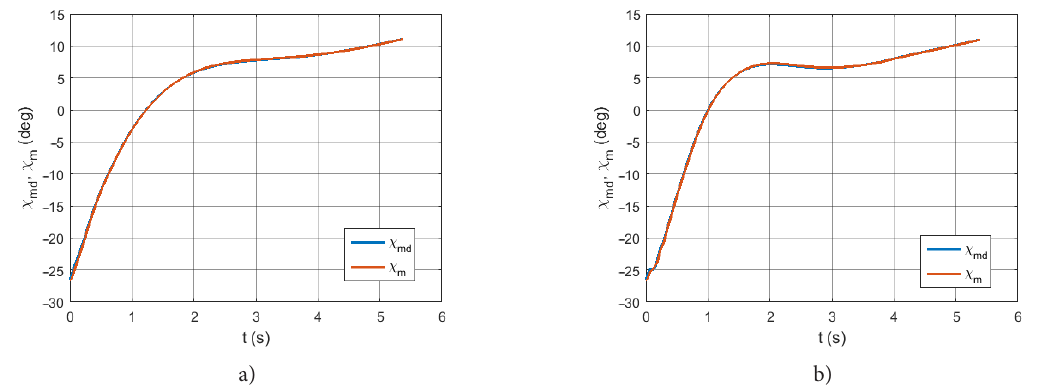
Figure 6. Actual m χ and desired md χ